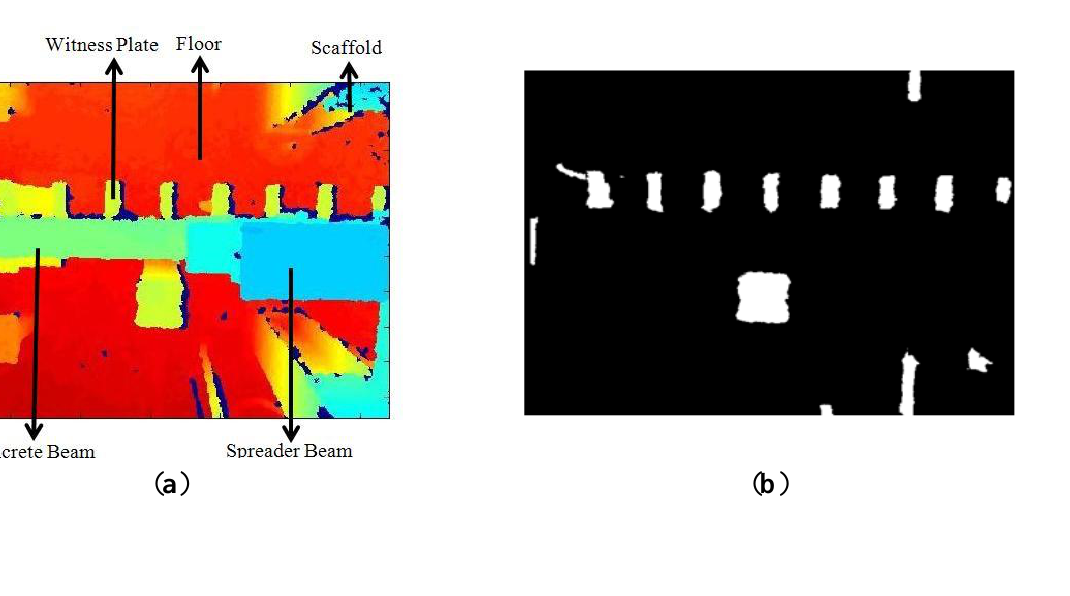
Figure 4. ( a ) Depth image from Microsoft Kinect, ( b ) The binary image after depth-based segmentation, ( c ) The binary image after eccentricity analysis, and ( d ) The final result after image